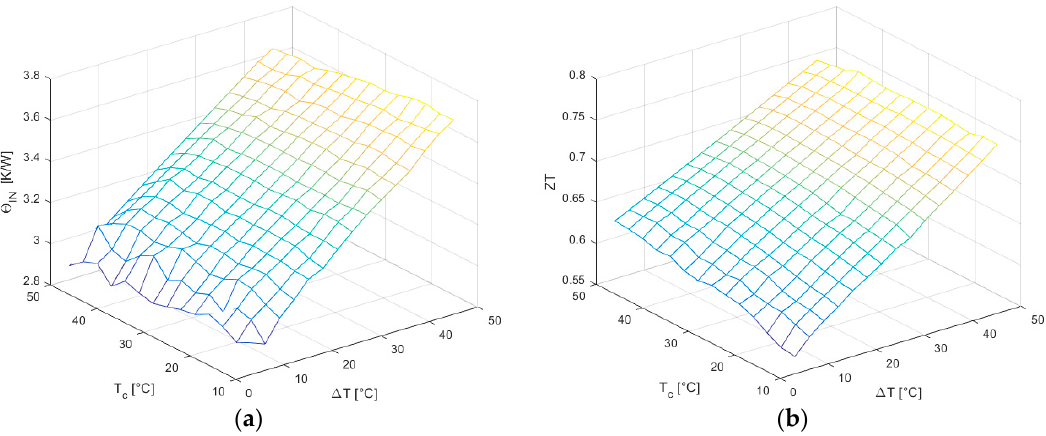
Figure 15. ( a ) Internal thermal resistance Θ IN ; ( b ) Figure of merit ZT